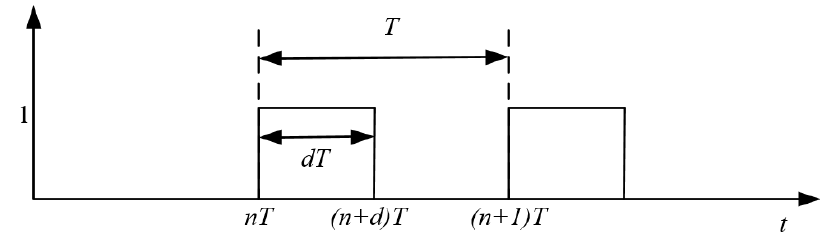
Figure 2. Impulse Figure 2. Impulse waveform.